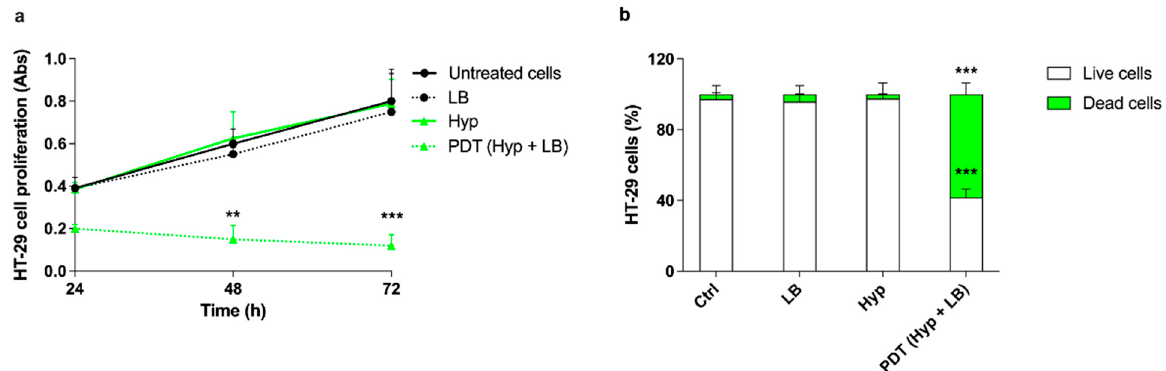
Figure 5 . Effects of hypericin-mediated photodynamic treatment on HT-29 cell proliferation. HT-29 cells were incubated for 24 h with 0.1 µ M Hyp and then exposed to LB (green LED at 1.5 W/cm 2 for 20 min). ( a ) Cell proliferation was evaluated by WST-1 assay 24, 48, and 72 h after treatment. Statistically significant difference versus untreated cells: ** p ≤ 0.01, *** p ≤ 0.001. ( b ) Cell death was evaluated, 48 h after the treatment, using flow cytometry with SYTOX™ green dead cell staining and expressed as cell percentage. Statistically significant difference versus untreated cells (Ctrl): ** p ≤ 0.01, *** p ≤ 0.001 ( n = 3).